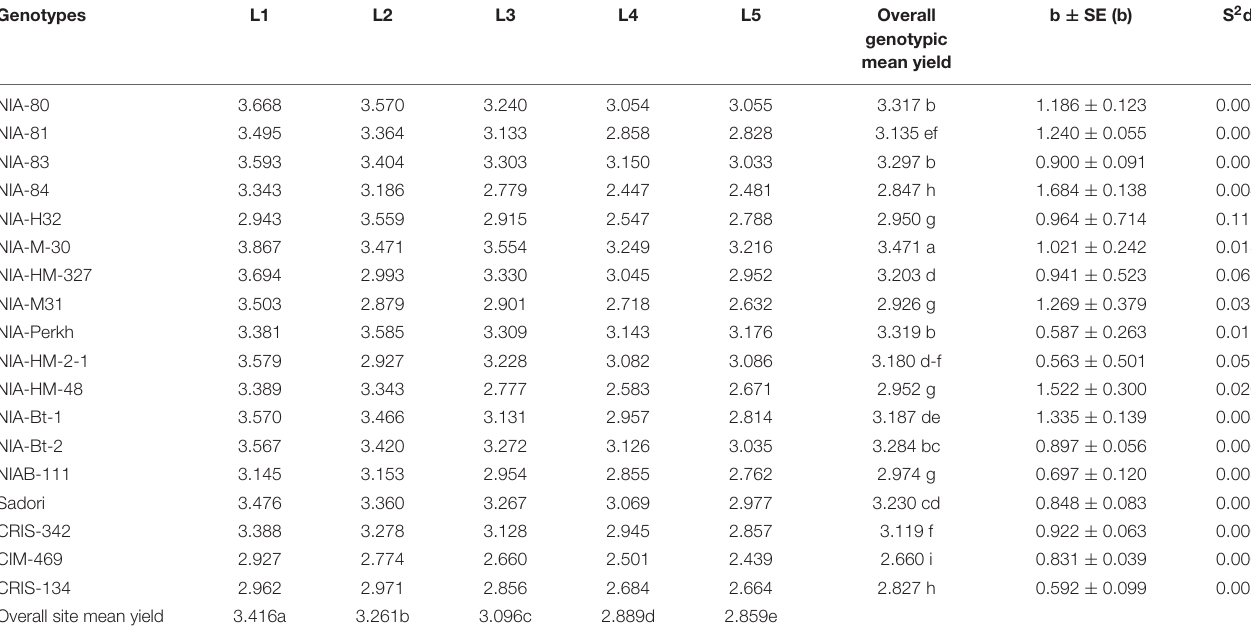
TABLE 4 | Seed cotton yield (tons/ha) and stability parameters for SCY of 18 selected genotypes tested over different locations during 2017–2018. Genotypes